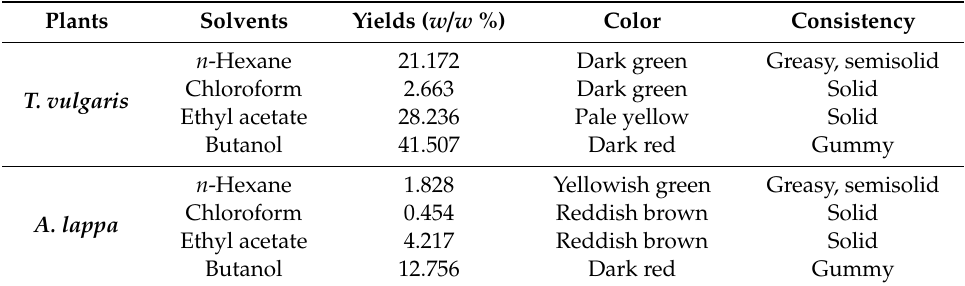
Table 1. The proportion of di ff erent solvent extractions of T. vulgaris and A. lappa. Plants Solvents Yields ( w / w %) Color Consistency n -Hexane 21.172 Dark green Greasy, semisolid Chloroform 2.663 Dark green Solid T. vulgaris Ethyl acetate 28.236 Pale yellow Solid Butanol 41.507 Dark red Gummy n -Hexane 1.828 Yellowish green Greasy, semisolid Chloroform 0.454 Reddish brown Solid A. lappa 4.217 Reddish brown Solid Dark red Gummy